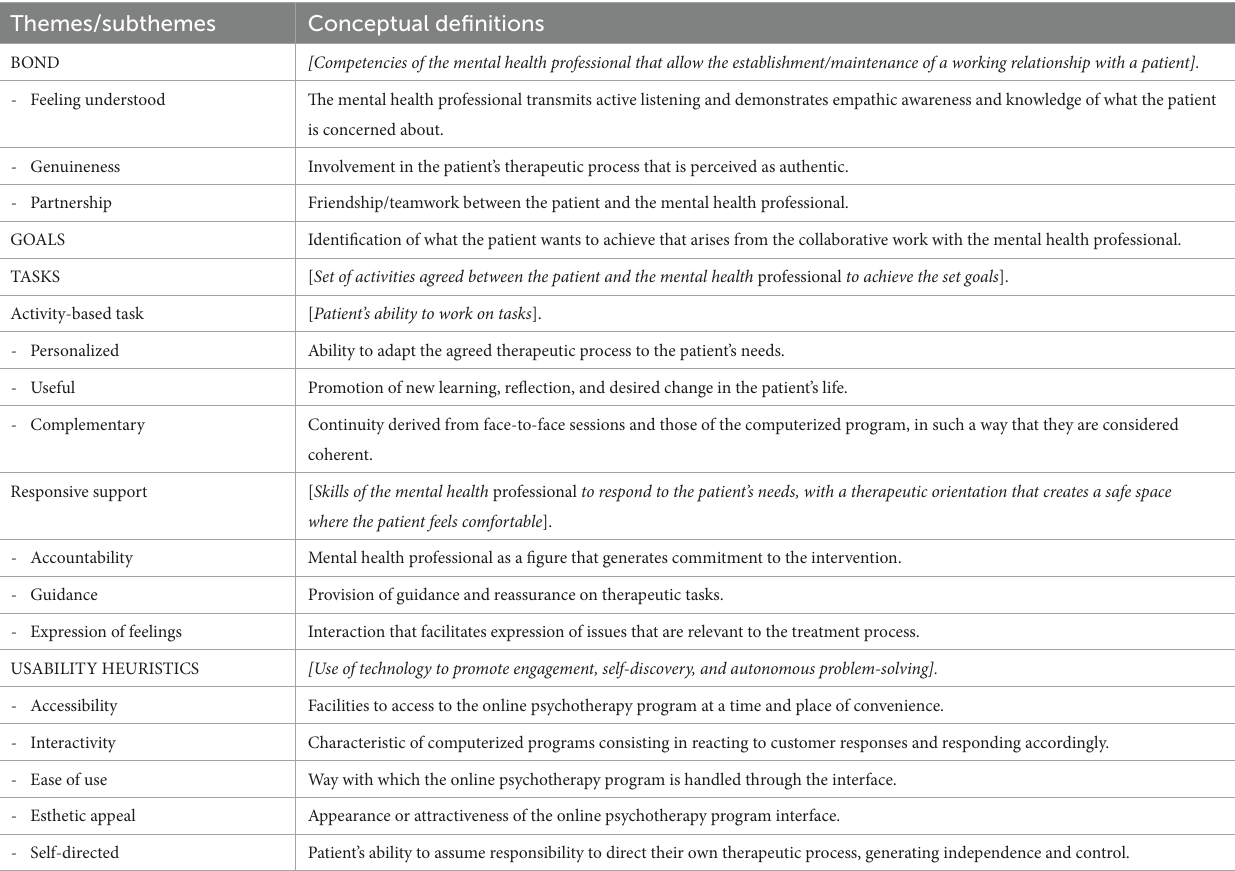
TABLE 1 Theme/subtheme definitions of the WA for b-CBT analytical framework (Doukani et al., 2020). Themes/subthemes Conceptual